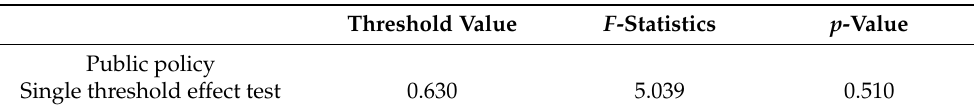
Table 5. Tests for the threshold effects between public policy and entrepreneurial activity in EU efficiency-driven countries.